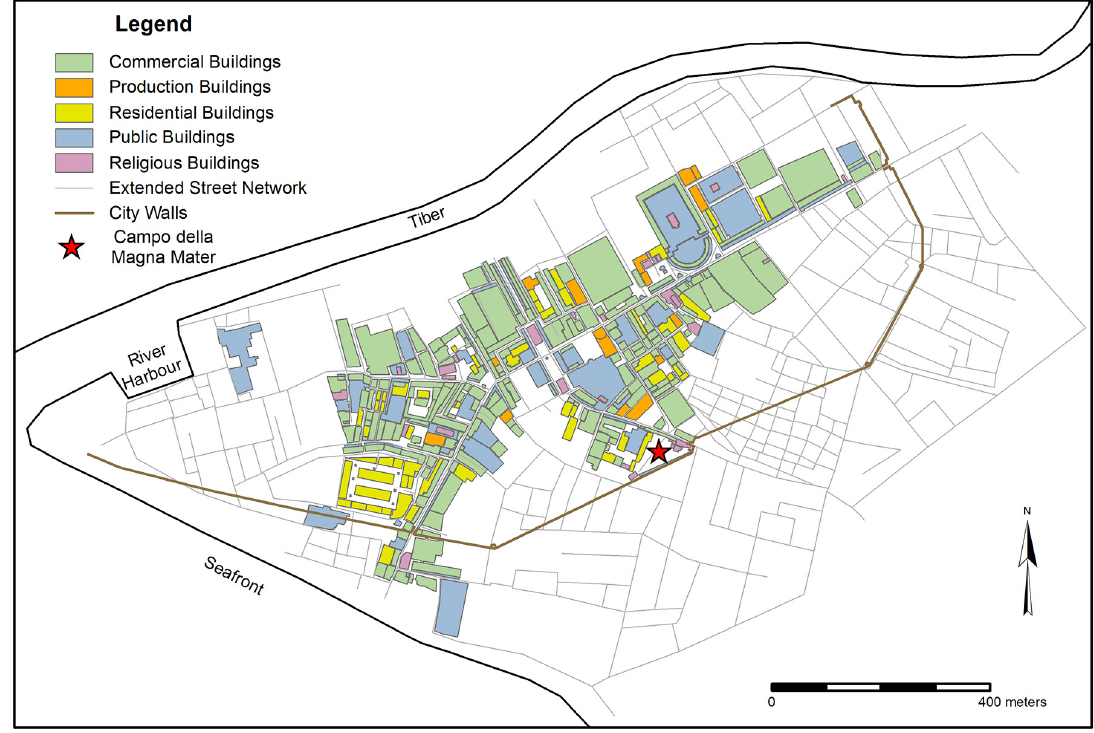
Figure 5. Plan of 2 nd century CE Ostia showing building classification categories and the extended street